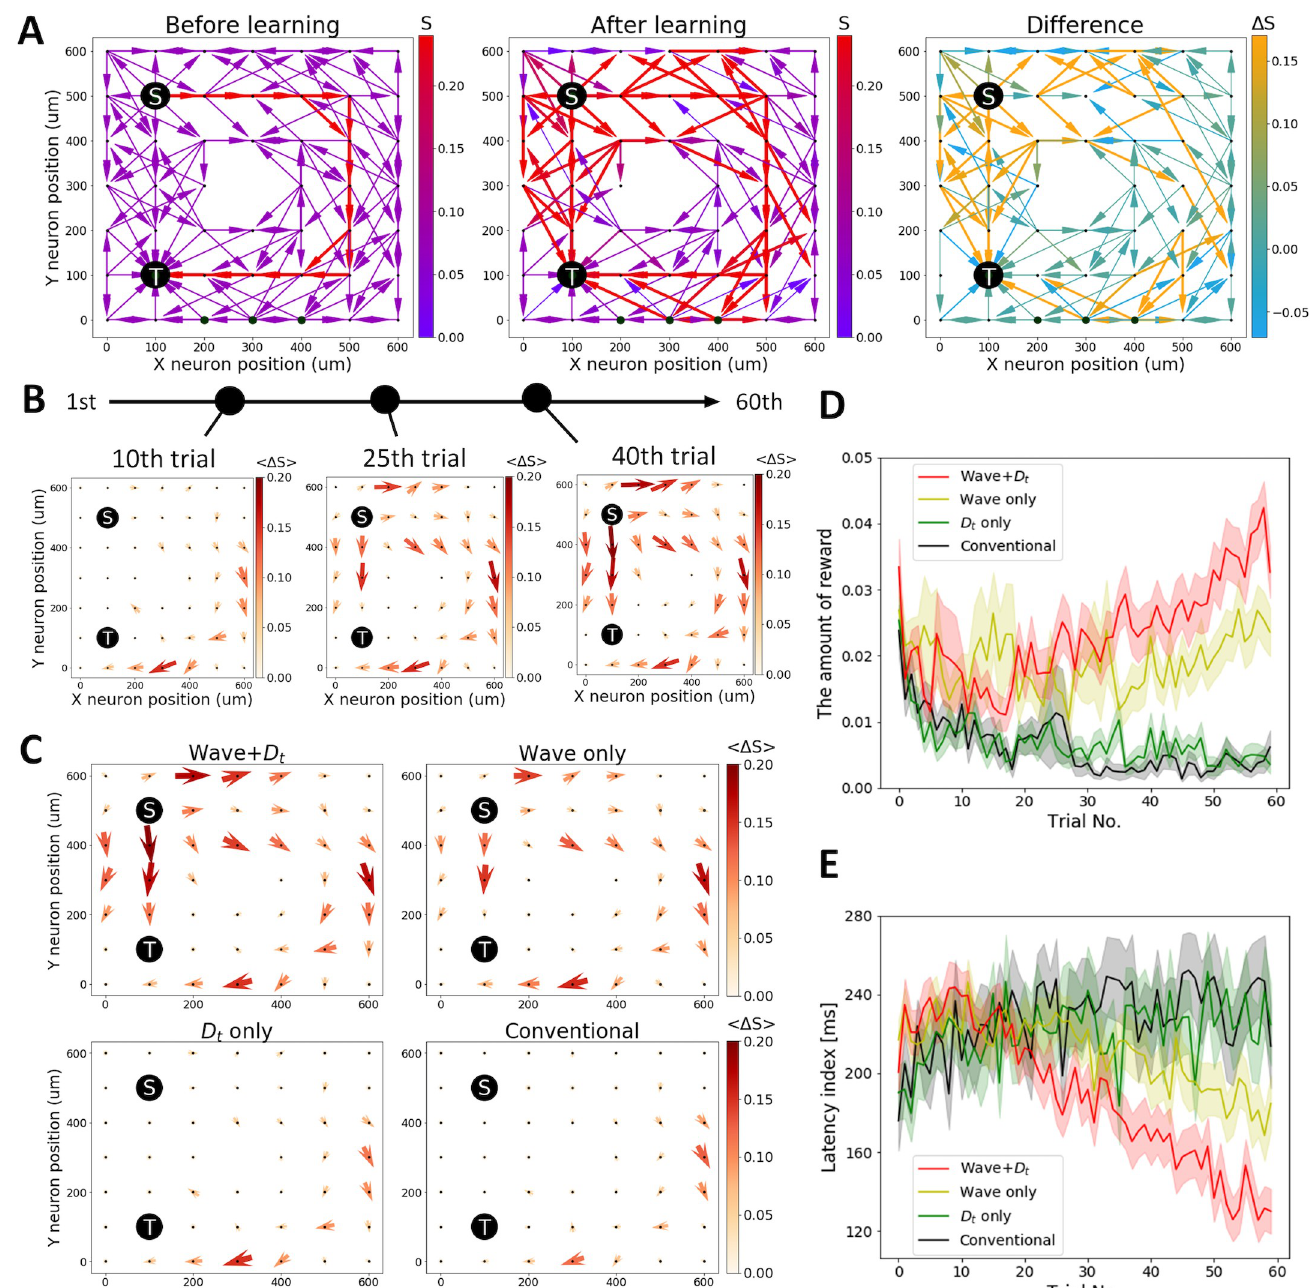
Fig 3. Wave propagation helps find a shortcut. (A) An example of a successful trial. Each panel represents the initial synaptic weight (Left), the last synaptic weight (Middle) and the difference between them (Right). Initially, a strong detour path from the stimulated neuron S on the upper-left at (100 μ m, 500 μ m) to the p target neuron T on the bottom-left at T (100 μ m, 100 μ m) is prepared. Neurons within 100 5 μ m are randomly connected with a probability of 0.5. Synaptic connections from S are all outward, while synaptic connections to T are all inward. At the end of the trial, the shortcut paths are strengthened while the detour paths are preserved. (B) The averaged synaptic weight difference from the initial trial to the 10 th , 25 th , and 40 th trials is plotted. The averaged synaptic weights are calculated by each neuron, including the direction of synaptic connection. ( C) The averaged synaptic weight difference from the initial trial and the last trial (the 60 th trial) is plotted. (D) The amount of reward signal is plotted. The wave conditions can successfully escape a local solution state and reach a better solution for this task. The error bar indicates the standard error of the mean. (E) The latency index takes the latency of the first spike in the target neuron after the stimulus onset if it is below 300 ms and takes 300 ms if the latency is above 300 ms. The condition with waves and tonic dopaminergic signal D t (red) shows the best performance, while the conventional model (black) fails. The error bar indicates the standard error of the mean.